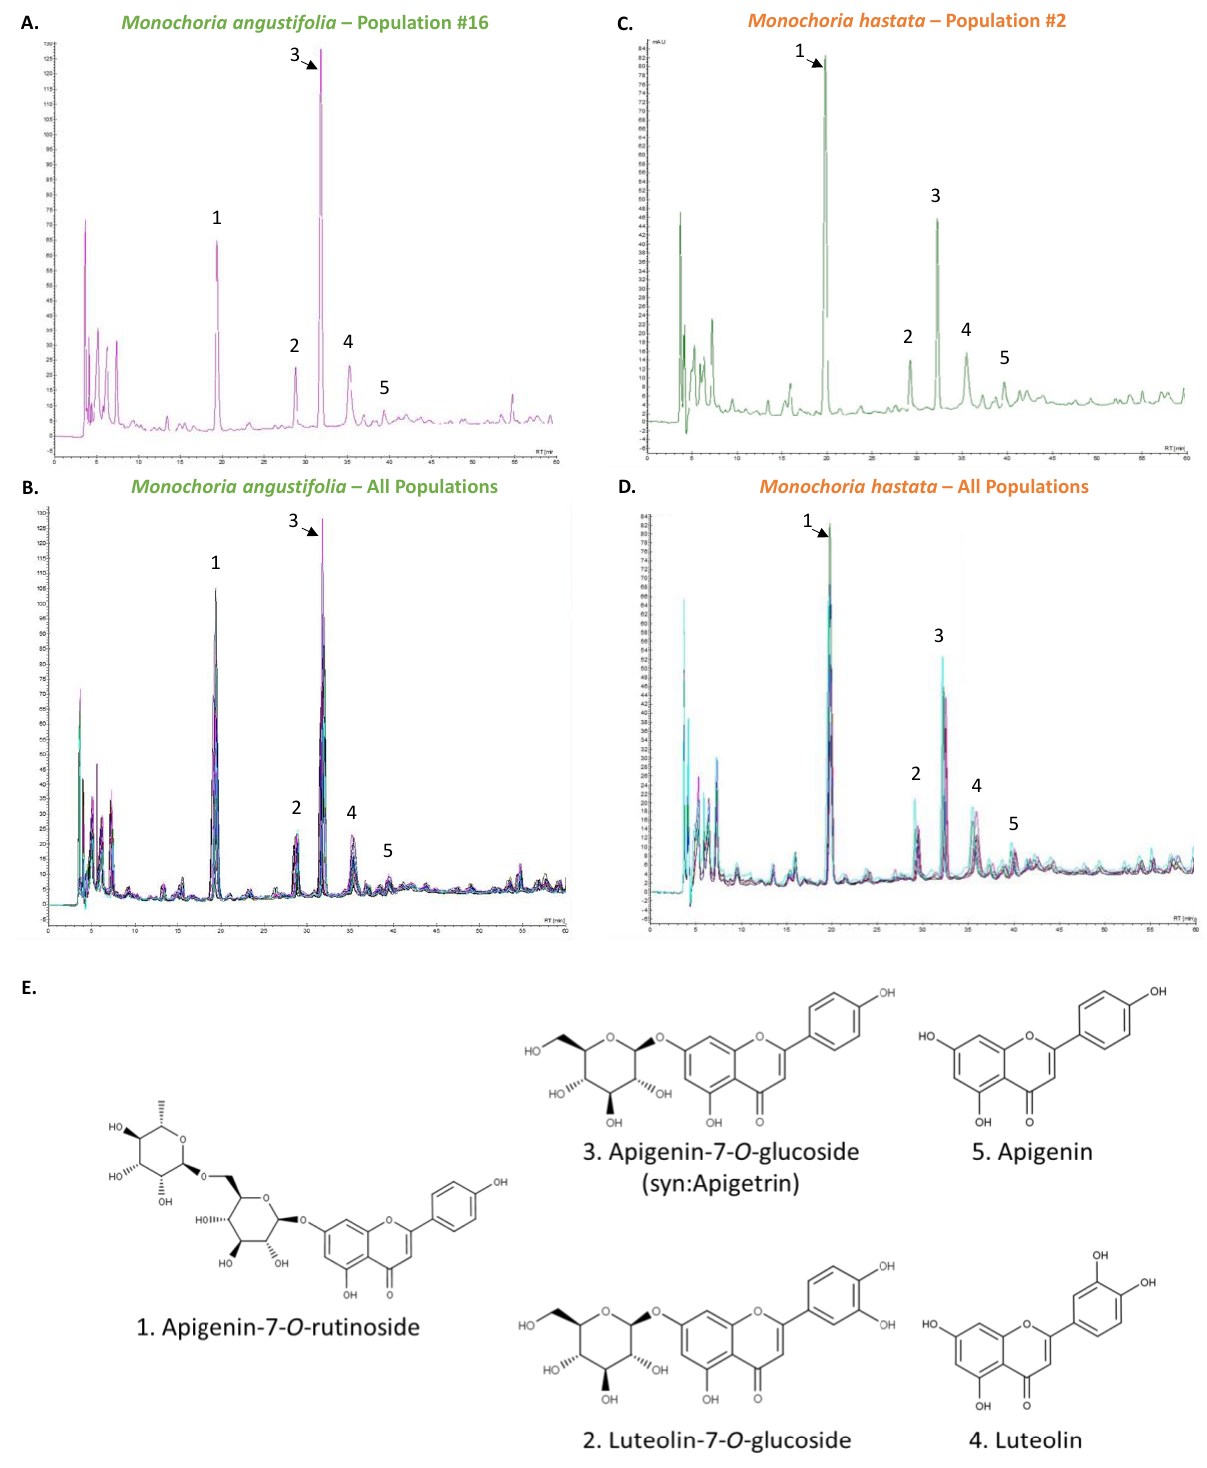
Figure 4. The HPLC chromatograms detected at 320 nm of ( A ) M. angustifolia population #16; ( B ) superimposed view of the M. angustifolia 25 populations; ( C ) M. hastata population #2; ( D ) superimposed view of the M. hastata 6 populations; ( E ) Structure of the main identified flavonoids: 1. apigenin-7- O -rutinoside; 2. luteolin-7- O -glucoside; 3. apigenin-7- O -glucoside (also known as apigetrin); 4. luteolin; 5. apigenin.